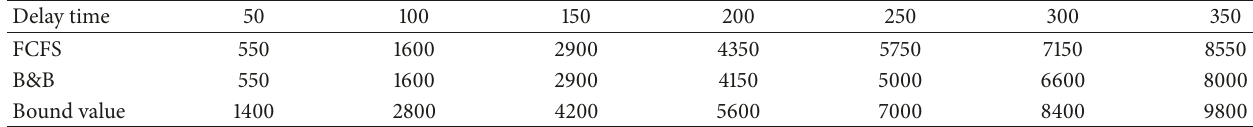
Table 4: Objective function and bound values in case of different